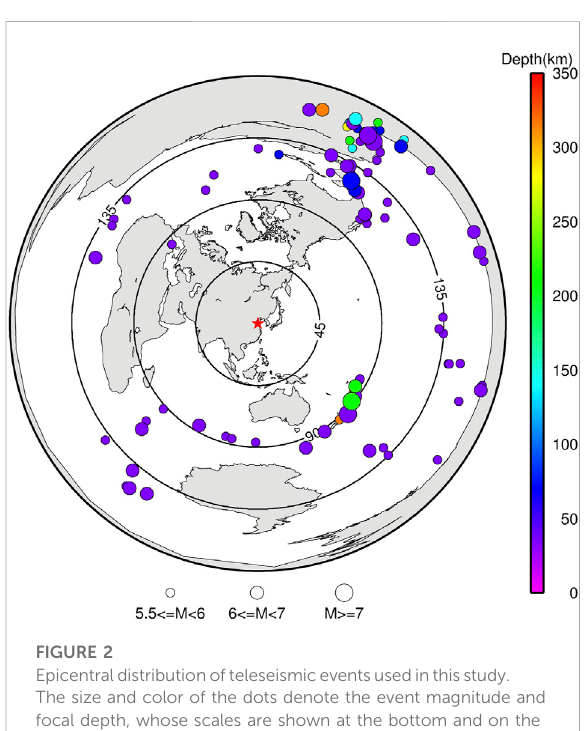
FIGURE 2 Epicentraldistributionofteleseismiceventsusedinthisstudy. The size and color of the dots denote the event magnitude and focal depth, whose scales are shown at the bottom and on the right, respectively. The red star denotes the center of our study